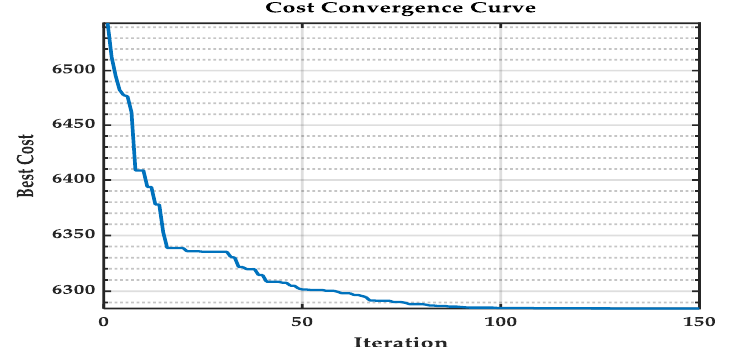
Figure 6. Cost convergence curve for Case 1.